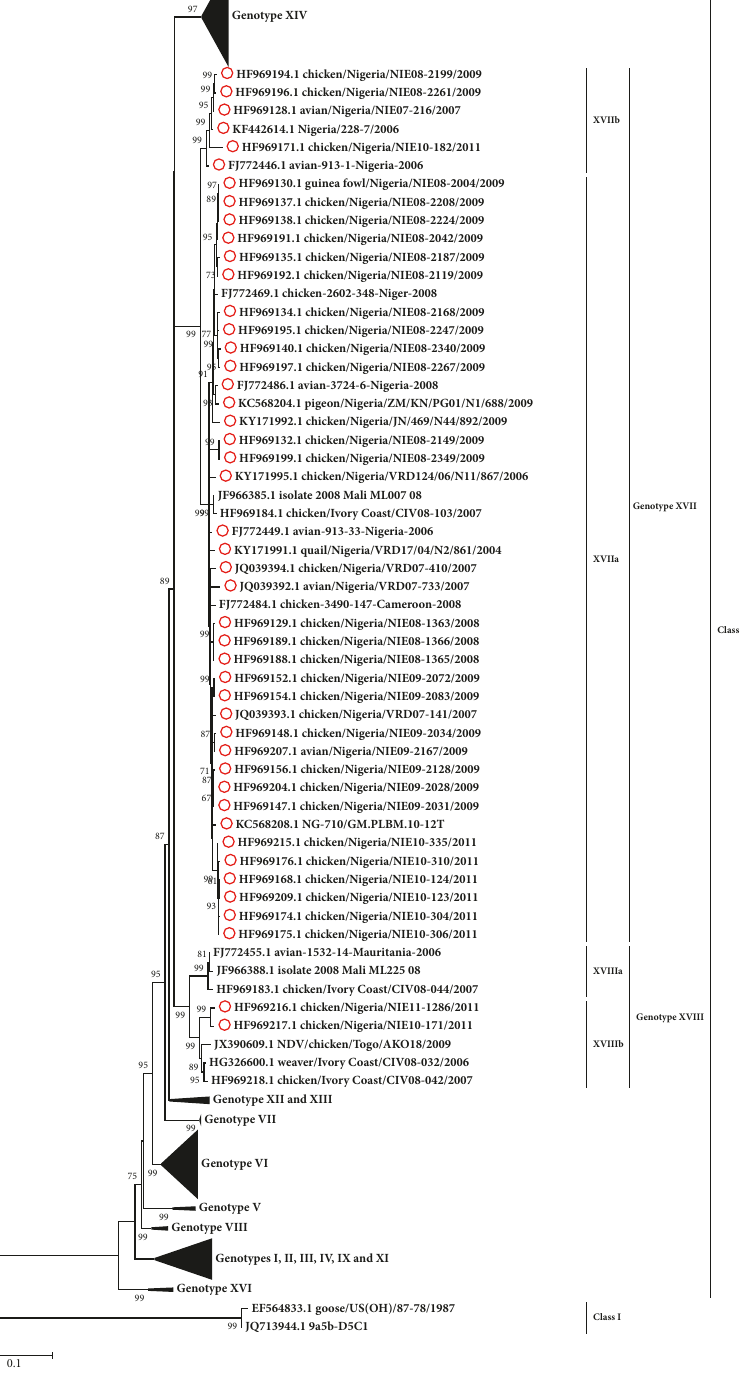
Figure 1: Molecular phylogenetic analysis of complete F coding regions (1662bp) for Nigerian Newcastle disease virus isolates . (a) Zoomed view of prevalent genotype VI isolates is shown. The coloured taxa indicate the subgenotypes with isolates prevalent in Nigeria (indicated with black icons at the node). (b) Relationship of Nigerian genotype XIV isolates with other reference strains is shown (all isolates prevalentin Nigeria are labelled with invertedtriangle). (c)Expanded view of Nigerian genotype XVII and XVIII isolates(labelled with circles at the node). The evolutionary history was inferred using the maximum likelihood method based on the Tamura 3-parametermodel. The tree with the highestlog likelihood (-22231.3479)is shown. The percentageof trees in whichthe associatedtaxa clusteredtogetheris shown next to the branches. Initial tree(s) for the heuristic search were obtained by applying the neighbor-joining method to a matrix of pairwise distances estimated using the maximum composite likelihood (MCL) approach. A discrete Gamma distribution was used to model evolutionary rate differences among sites (5 categories (+ G , parameter = 0.6931)). The tree is drawn to scale, with branch lengths measured in the number of substitutions per site. The analysis involved 195 nucleotide sequences. Codon positions included were 1st+2nd+3rd+Noncoding. All positions containing gaps and missing data were eliminated. Evolutionary analyses were conducted in MEGA6